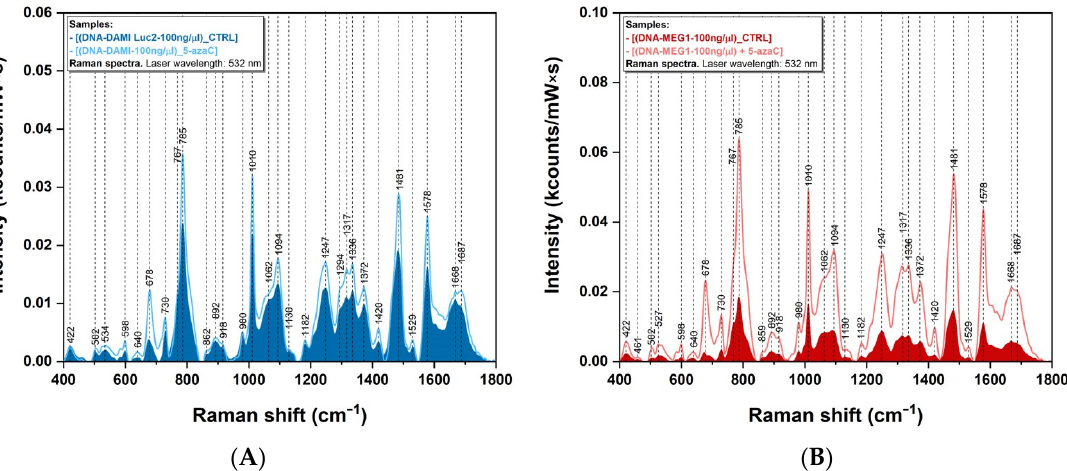
Figure 3. Raman spectra of DNA samples obtained from DAMI Luc2 ( A ) and MEG-1 ( B ) cell lines before (filled area) and after treatment with 5-azaC. The spectra were collected using a 532 nm laser.